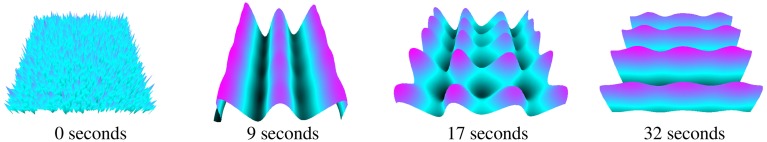
Turing patterns in neural field activity forming over time during the same simulation.